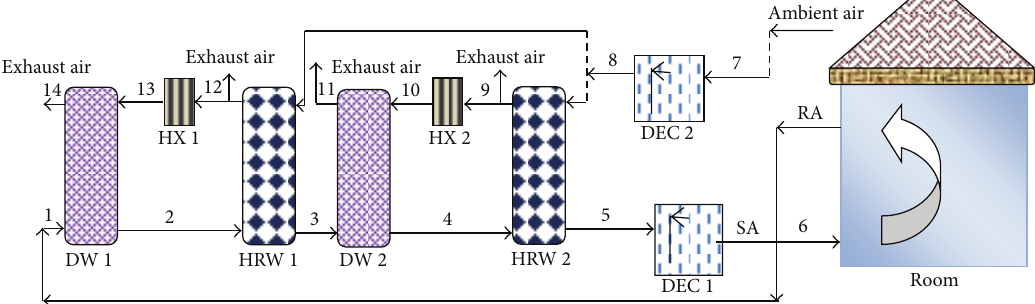
Figure 4: Schematic of two-stage solar desiccant cooling system-recirculation